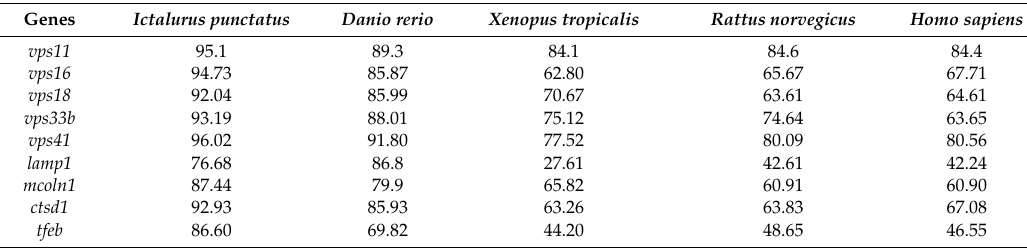
Table 2. Amino acid sequence identity of autolysosome-related genes between P. fulvidraco and other species